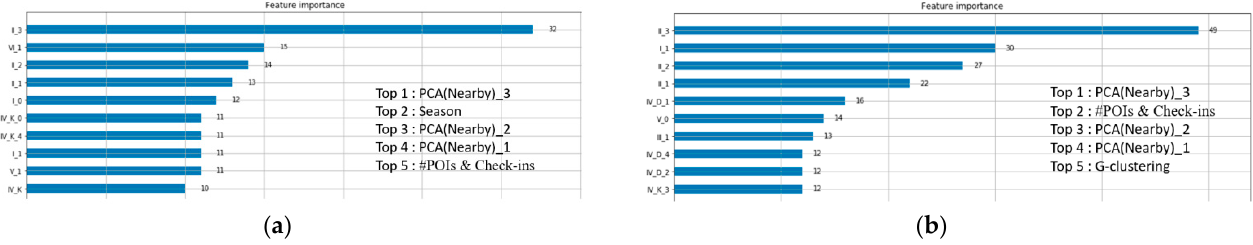
Figure 11. Feature importance of Batch 3. ( a ) Represents rental demand, and ( b ) represents the drop-off one.